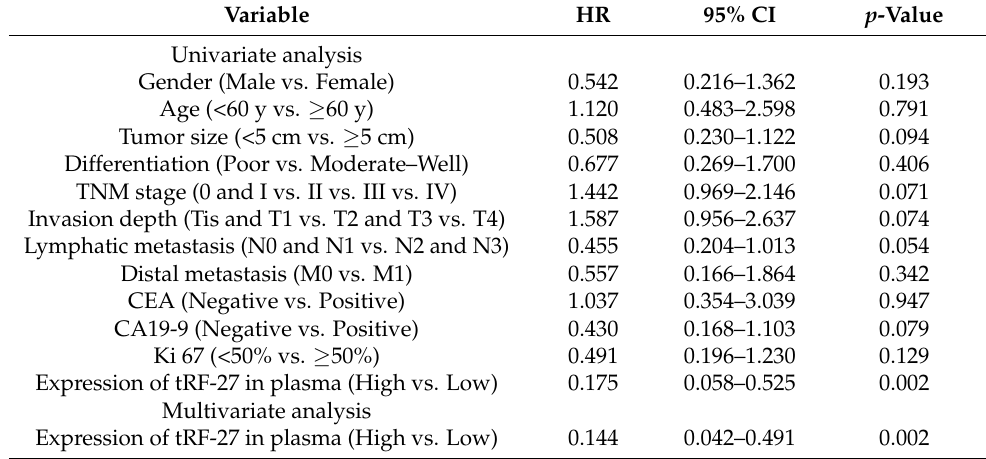
Table 2. Plasma tRF-27 is an independent predictor of overall survival of gastric cancer patients. Variable HR 95% CI p -Value Univariate analysis Gender (Male vs. Female) 0.542 0.216–1.362 0.193 Age (<60 y vs. ≥ 60 y) 1.120 0.483–2.598 0.791 Tumor size (<5 cm vs. ≥ 5 cm) 0.508 0.230–1.122 0.094 Differentiation (Poor vs. Moderate–Well) 0.677 0.269–1.700 0.406 TNM stage (0 and I vs. II vs. III vs. IV) 1.442 0.969–2.146 0.071 Invasion depth (Tis and T1 vs. T2 and T3 vs. T4) 1.587 0.956–2.637 0.074 Lymphatic metastasis (N0 and N1 vs. N2 and N3) 0.455 0.204–1.013 0.054 Distal metastasis (M0 vs. M1) 0.557 0.166–1.864 0.342 CEA (Negative vs. Positive) 1.037 0.354–3.039 0.947 CA19-9 (Negative vs. Positive) 0.430 0.168–1.103 0.079 Ki 67 (<50% vs. ≥ 50%) 0.491 0.196–1.230 0.129 Expression of tRF-27 in plasma (High vs. Low) 0.175 0.058–0.525 0.002 Multivariate analysis Expression of tRF-27 in plasma (High vs. Low) 0.144 0.042–0.491 0.002 HR, hazard ratio; CI, confidence